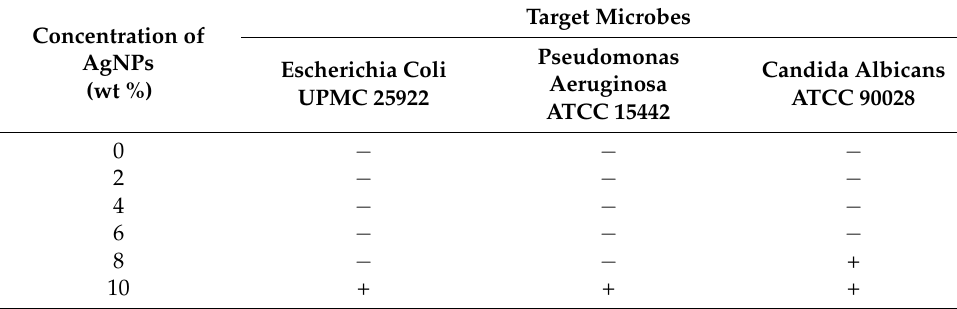
Table 3. Antimicrobial properties of kenaf/HDPE composite materials.